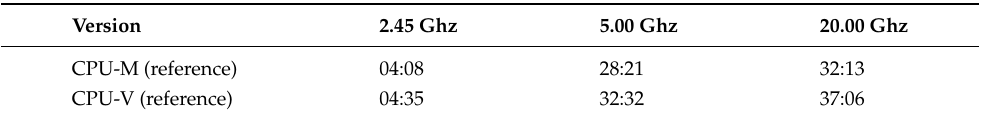
Table 5. Execution times obtained in serial form with the CPU, expressed in mm:ss, for the open space